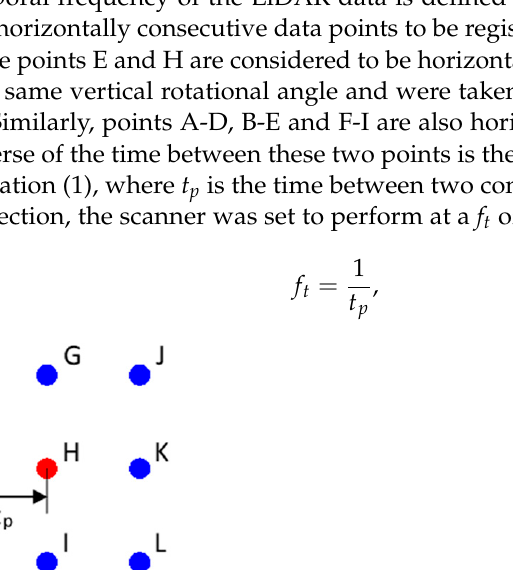
Figure 2. Ripple pattern found in the point cloud of the collected field data caused by operating traffic.